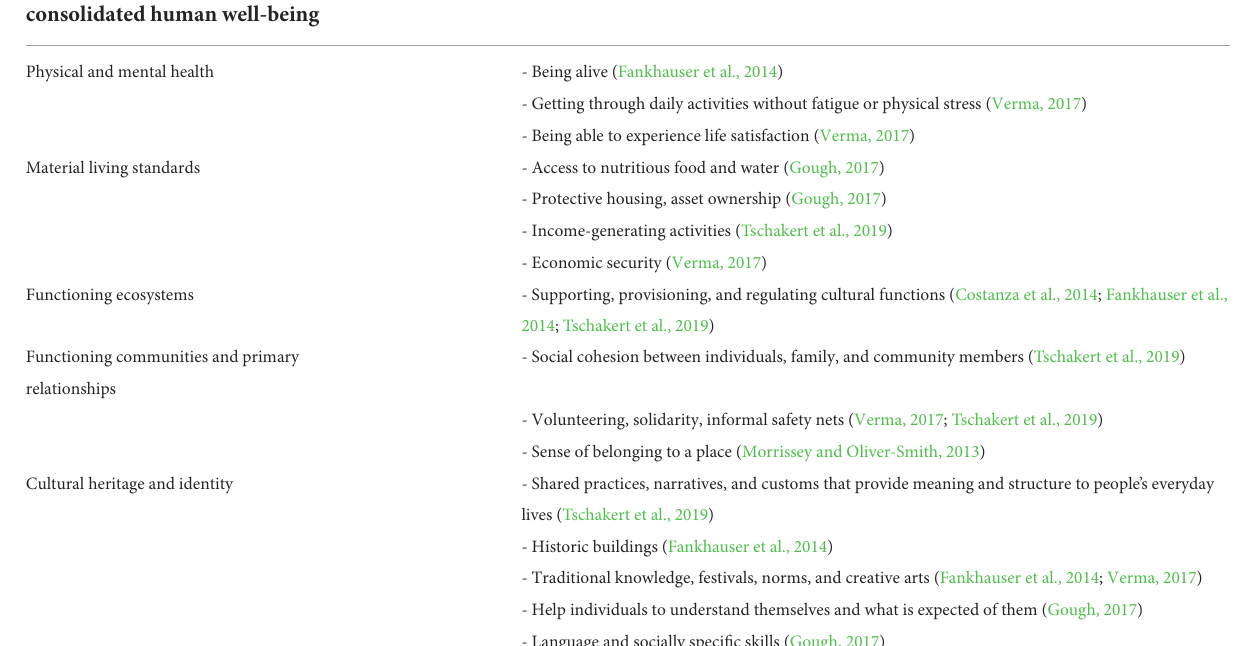
TABLE 1 Consolidated domain suggestions based on well-being and loss and damage domains as identified in Fankhauser et al. (2014), Gough (2017), Verma (2017), and Tschakert et al. (2019). Loss and damage domain based